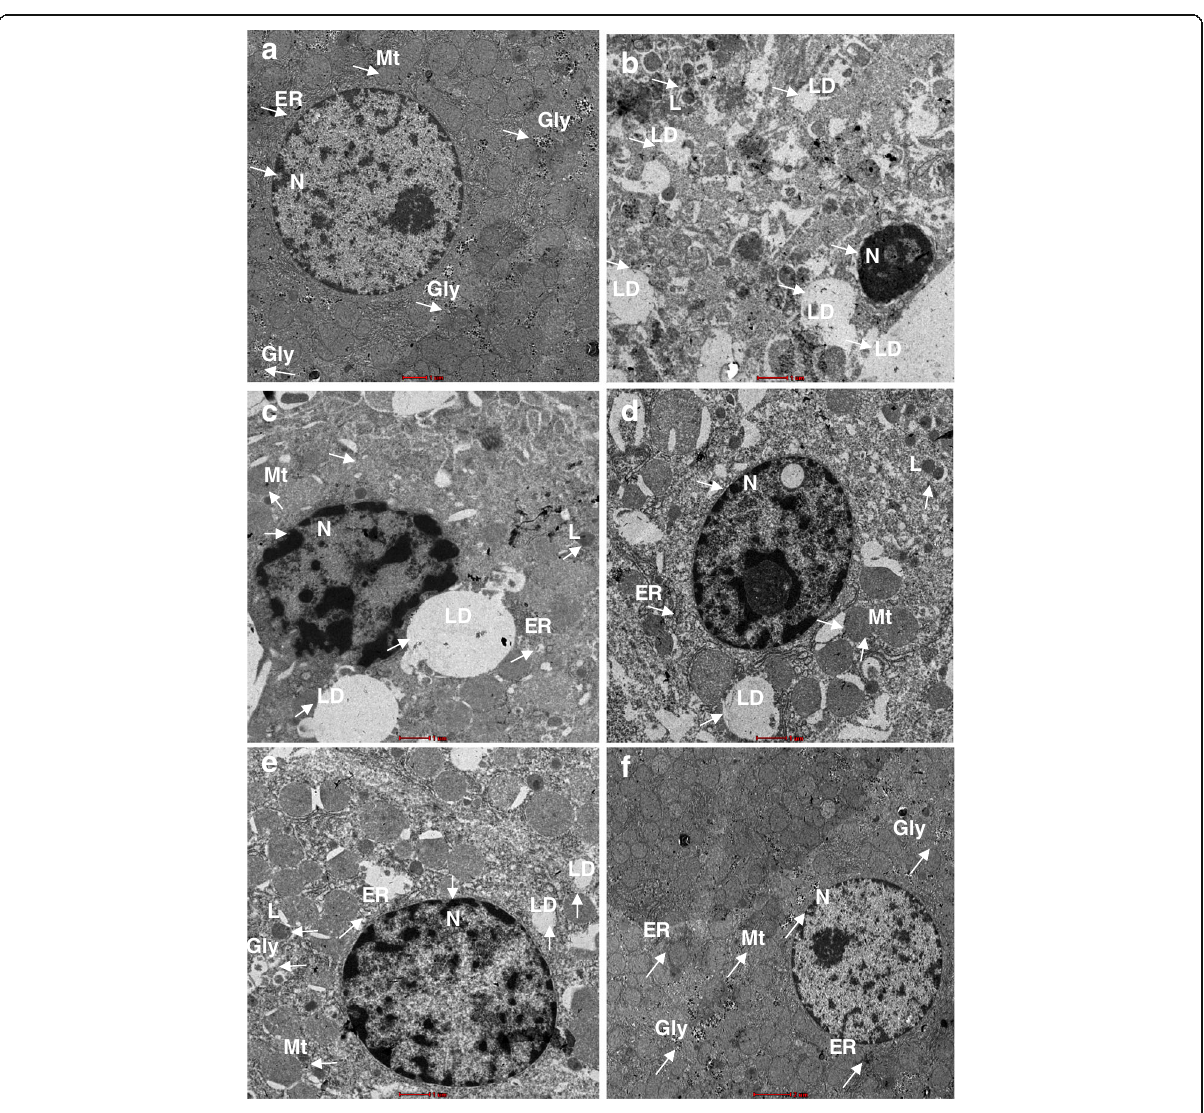
Fig. 7 Protective effect of C. nudiflora on the ultrastructure of hepatocytes damaged by CCl4. a (×690) Control; hepatocytes show normal ultrastructure. b (×890) CCl4 (1 ml/kg b.wt.); glycogen loss, large lipid droplets (LD), degenerated nucleus, and disrupted endoplasmic reticulum are seen. c (×890) C. nudiflora (150 mg/kg b.wt. + CCl 4 ); mitochondria are visible, and lipid droplets are present. d (×890) C. nudiflora (300 mg/kg b.wt. + CCl 4 ); disrupted nuclear membrane and dilations in the endoplasmic reticulum are recovered, and lipid droplets are present. e (×89×) C. nudiflora (450 mg/kg b.wt. + CCl 4 ); disrupted nuclear membrane and dilations in the endoplasmic reticulum are recovered, and lipid droplets are still present. The number of mitochondria and glycogen granules is increased. f (×550) C. nudiflora (450 mg/kg b.wt.) normal